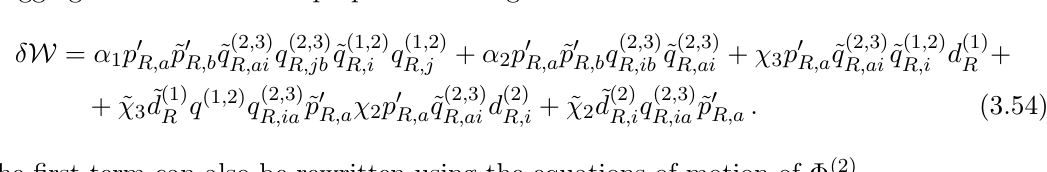
Figure 14 . Quiver diagram after the application of Aharony duality on the left node. This coincides with the one of (cid:12)gure 9 predicted by the recombination duality in the case N = 3 and k = 3. Plugging this back in the superpotential we